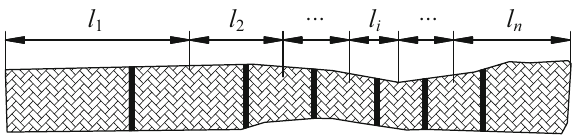
Fig. 2 Schematic for the coal seam reserve calculation